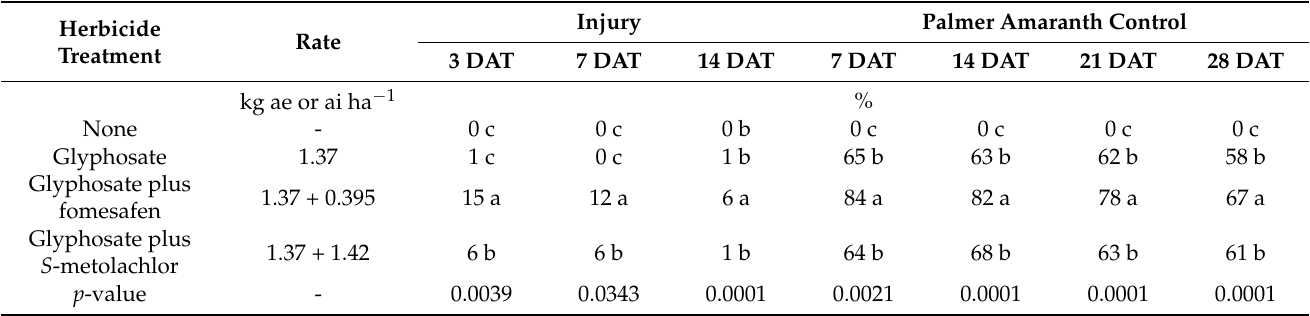
Table 2. Soybean injury 3, 7, and 14 d after treatment (DAT) and Palmer amaranth control 7, 14, 21, and 28 DAT with tank mixtures of POST herbicide treatments and cytokinin products applied at the V3 growth stage in Stoneville, MS, in 2015 and 2016 †